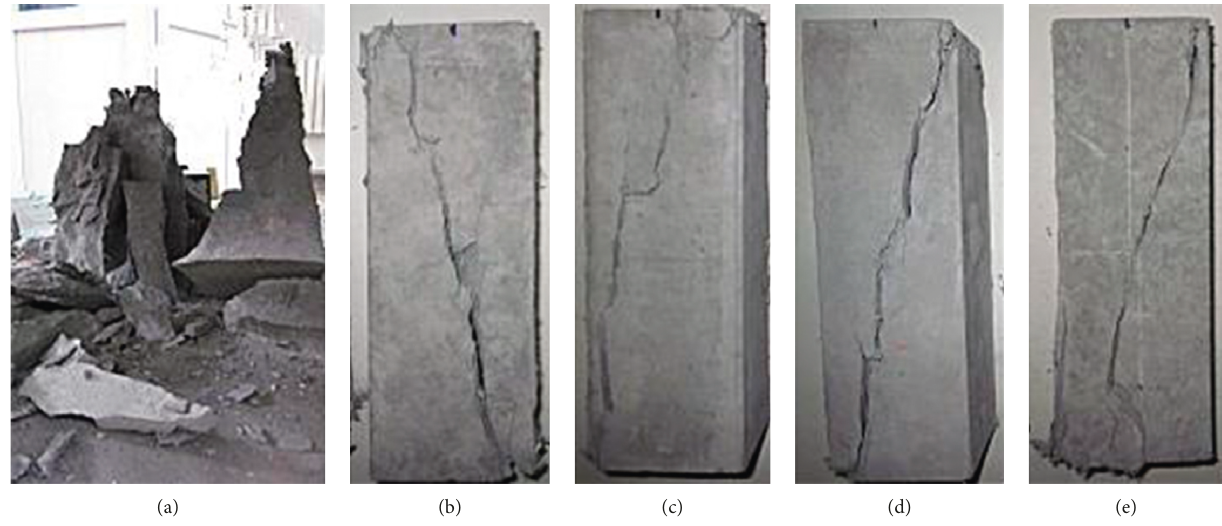
Figure 2: Typical failure mode of specimens. (a) Matrix, (b) HDC-2, (c) HDC-4, (d) HDC-5, and (e) HDC-6.